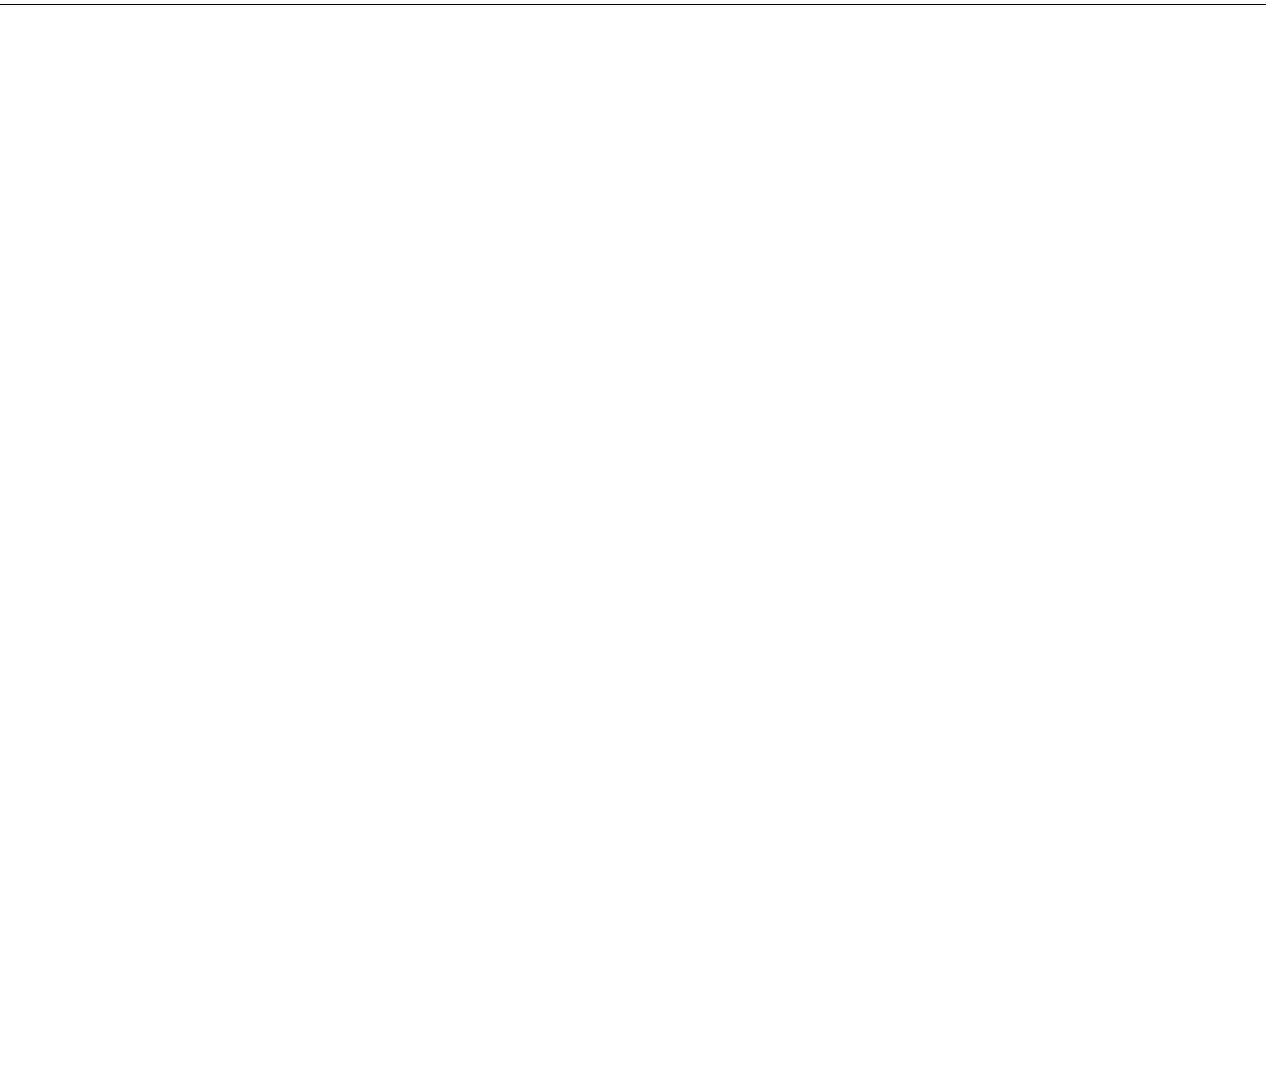
Keywords: dietary fiber, SCFA, immune system,